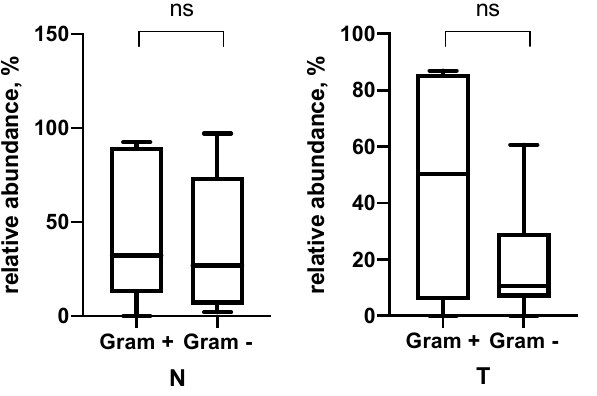
Figure 3. The relative content of Gram–positive and Gram–negative bacteria in the conditionally normal and tumor tissue of the